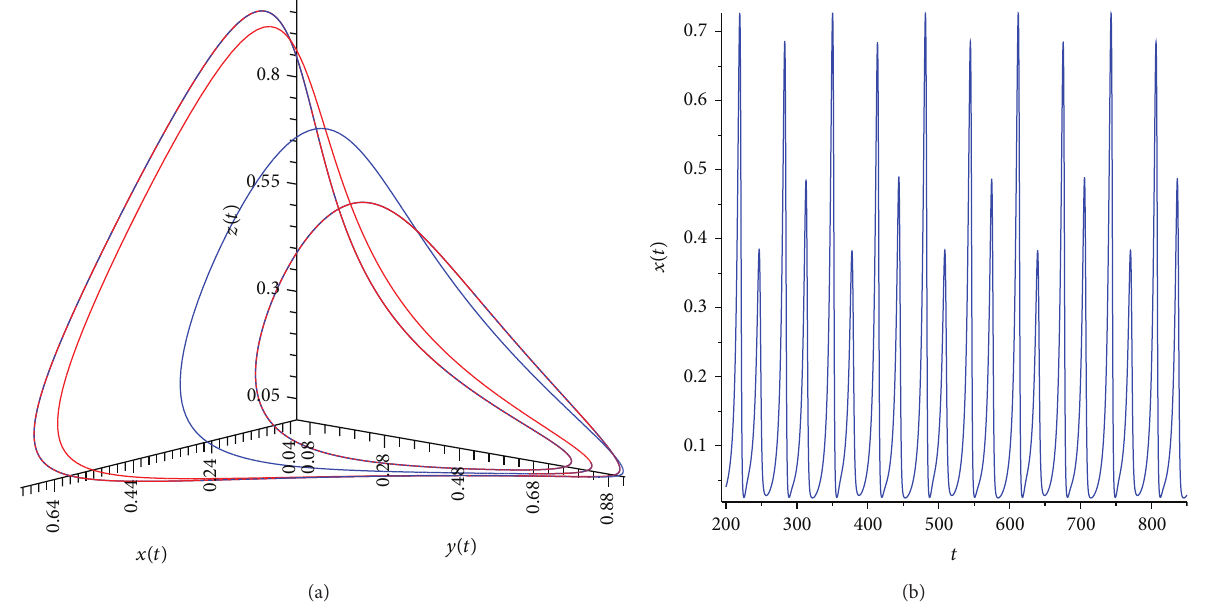
Figure5:(a)Periodicorbitofperiod 4𝑇 ,for 𝑎 = 0.948 .Integrationtime: [1500, 1600] .Initialconditions: (0.1325, 0.6687, 0.19) , (0.13, 0.6, 0.2) . (b) Periodic behaviour of the coordinate 𝑥(𝑡) of the solution in (a). Integration time: [1500, 1600] . Initial conditions: (0.1325, 0.6687, 0.2) .